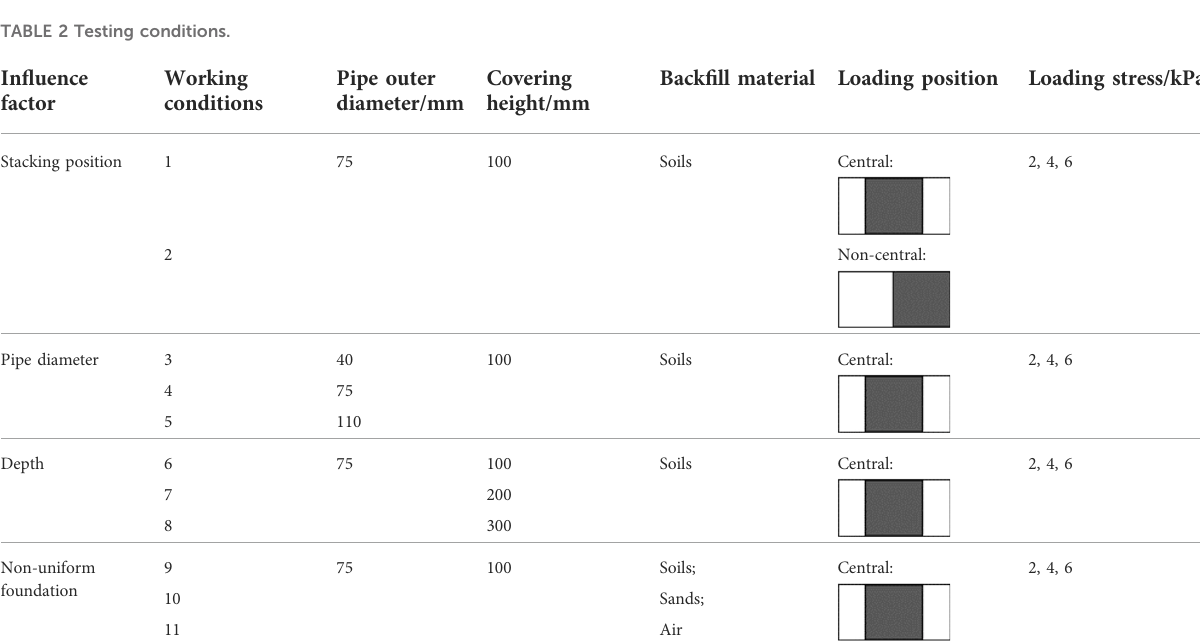
TABLE 2 Testing